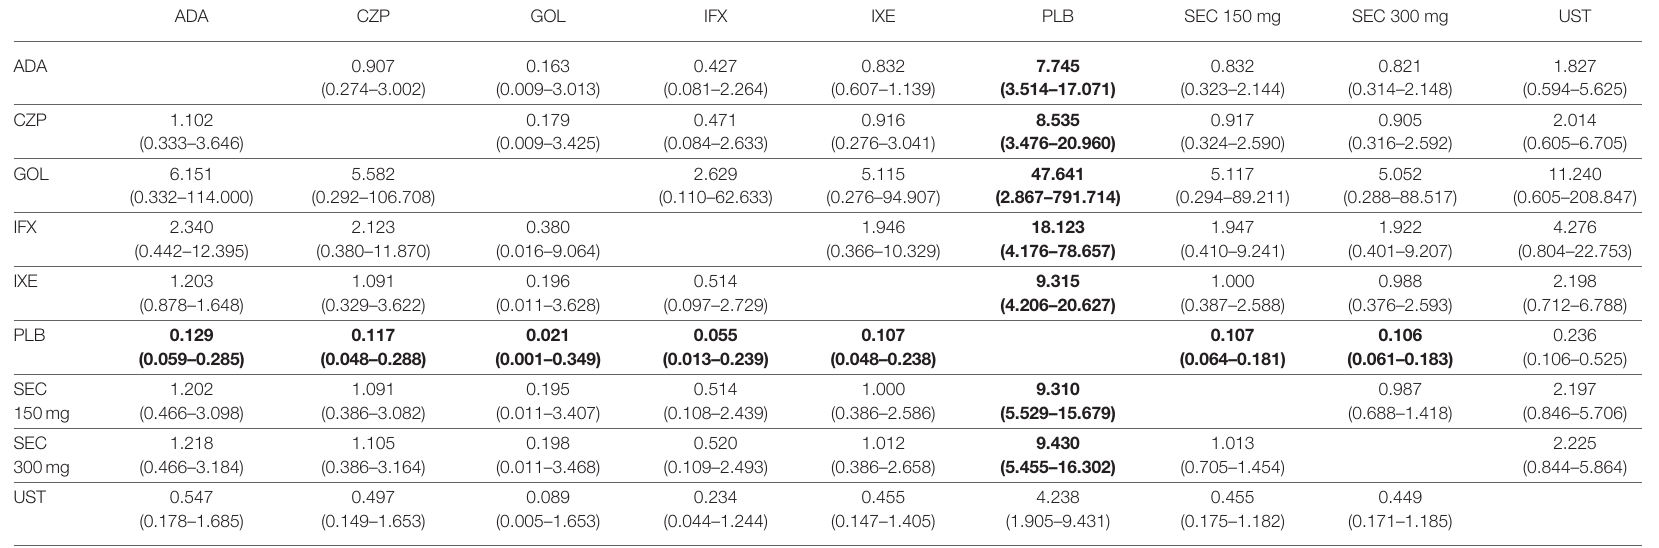
TABLE 4 | NMA results from the network of biologic therapies in the outcome ACR70. ADA